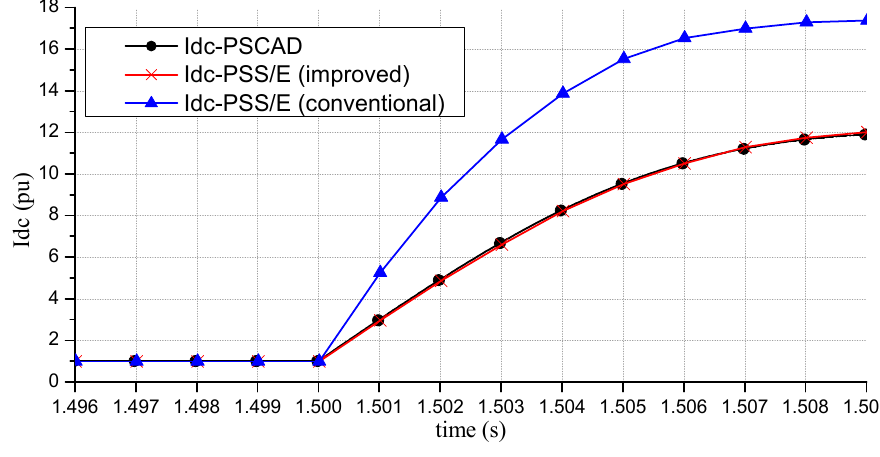
Figure 6. Comparisons of the improved/conventional MMC electromechanical model with the detailed electromagnetic model.